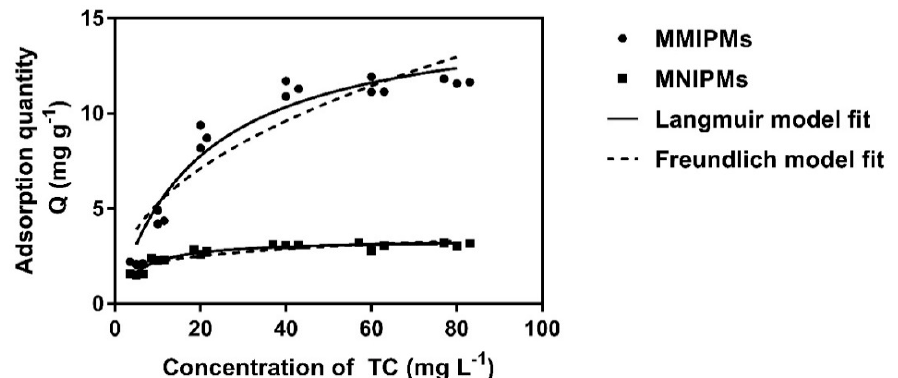
Figure 7. The equilibrium isotherm data of MMIPMs and MNIPMs toward TC were fitted with the Langmuir and Freundlich models.